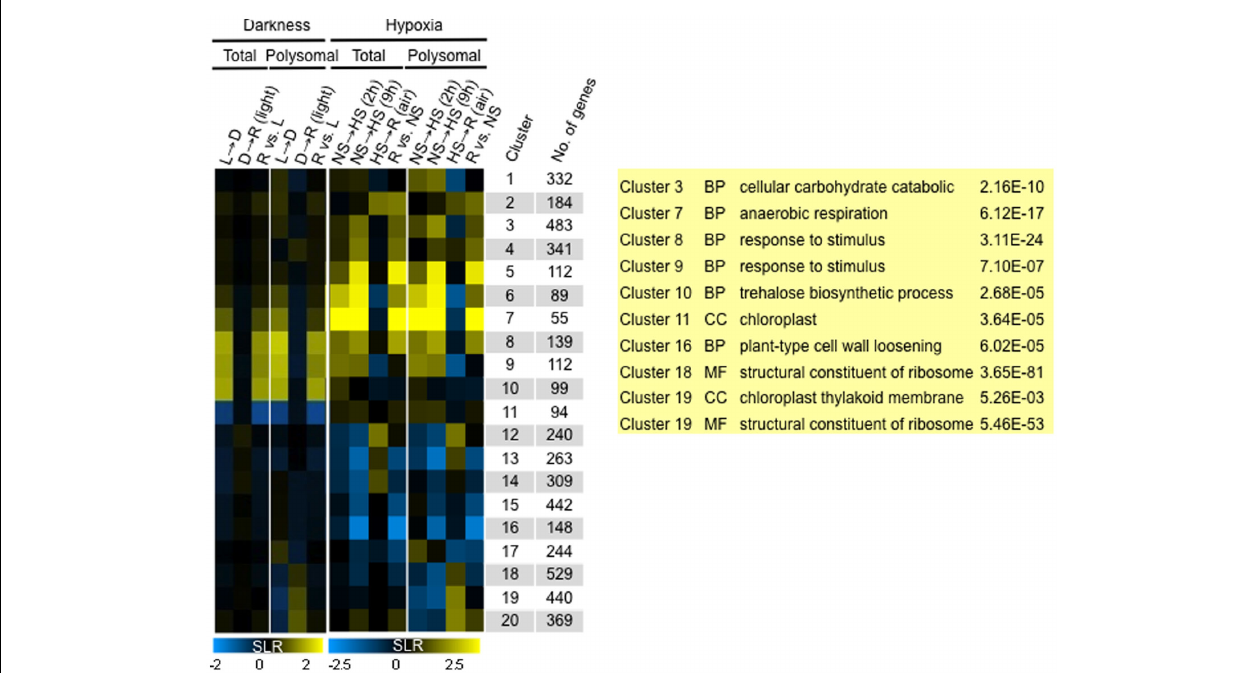
20 clusters of mRNAs that displayed similar responses to light availability and low oxygen treatment based on the total and polysomal mRNA populations. Color indicates increase (yellow), decrease (blue), or no-change (black) in mRNA abundance. Columns indicate cluster ID, number of genes (No. genes). Dark/Light (L → D), Re-illumination/Dark (D → R), and Re-illumination/Light (R versus L), 2h hypoxia/2h non-stress [NS → HS (2h)], 9h hypoxia/9h non-stress [(NS → HS (9h)], 1h recovery from 9h hypoxia/9h hypoxia [HS → R (air)], and 1h recovery from 9h hypoxia/9h non-stress (R versus